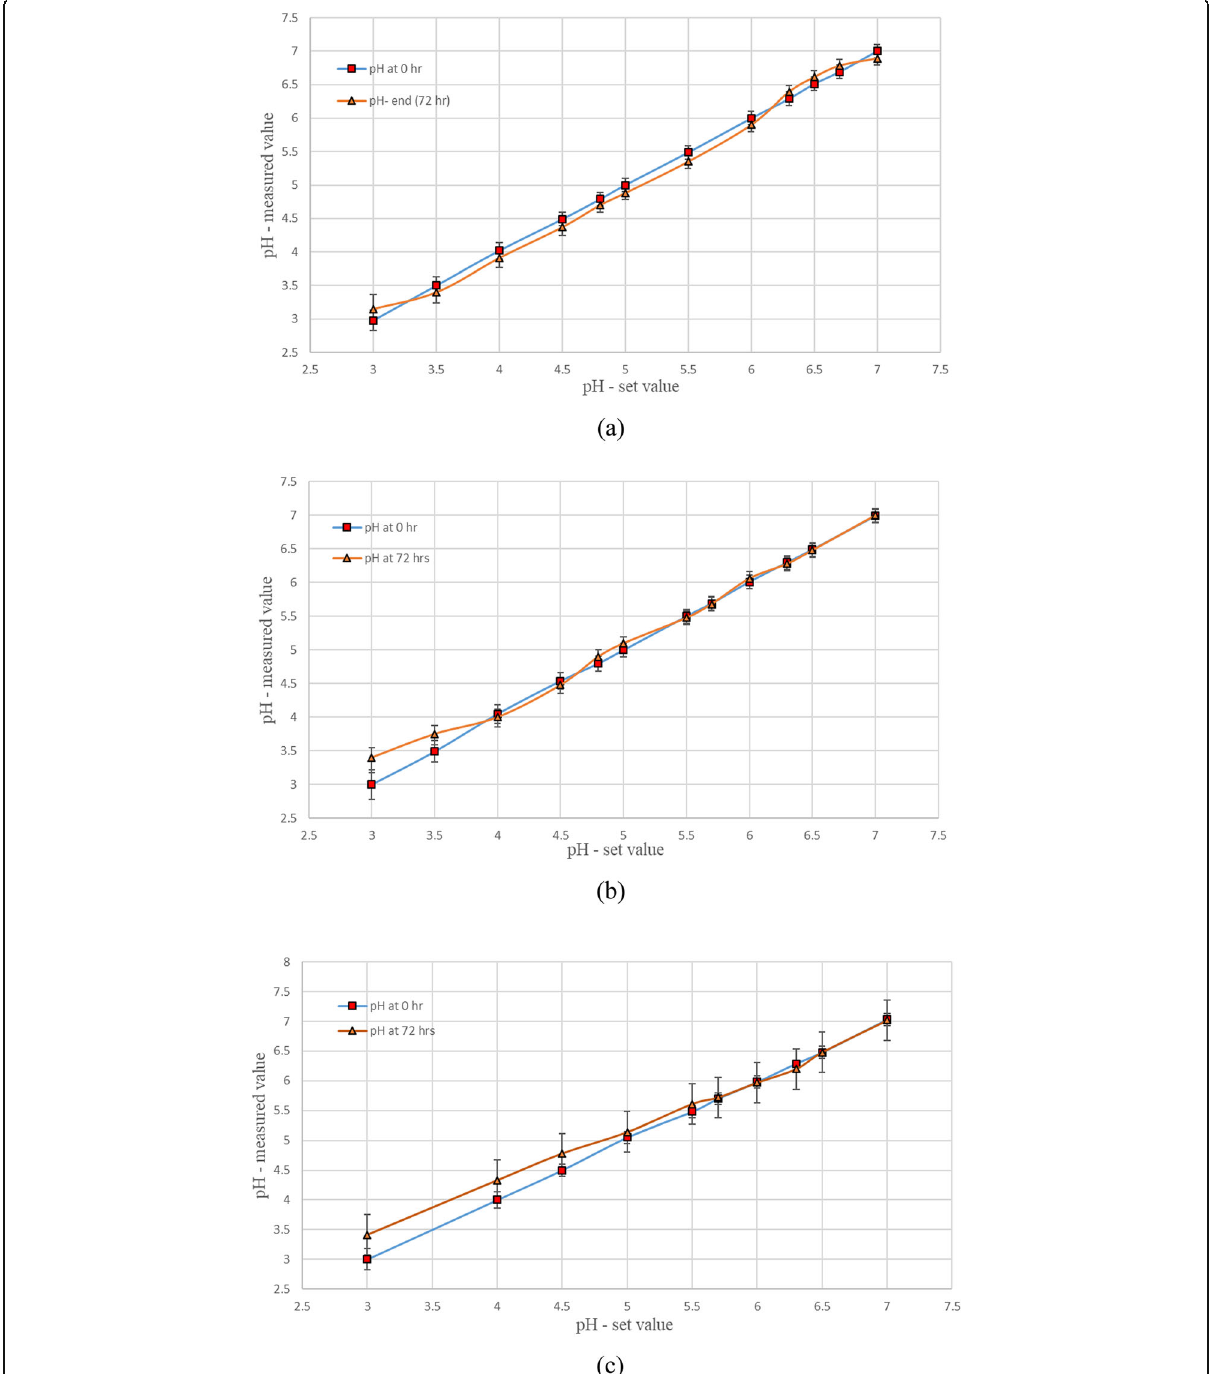
Fig. 1 pH data corresponding to time intervals from 0 h to 72 h during enzymatic hydrolysis using three different enzymes a Celluclast® 1.5L with Novozymes 188, b endo-1,4- β -xylanase, and c Cellic®